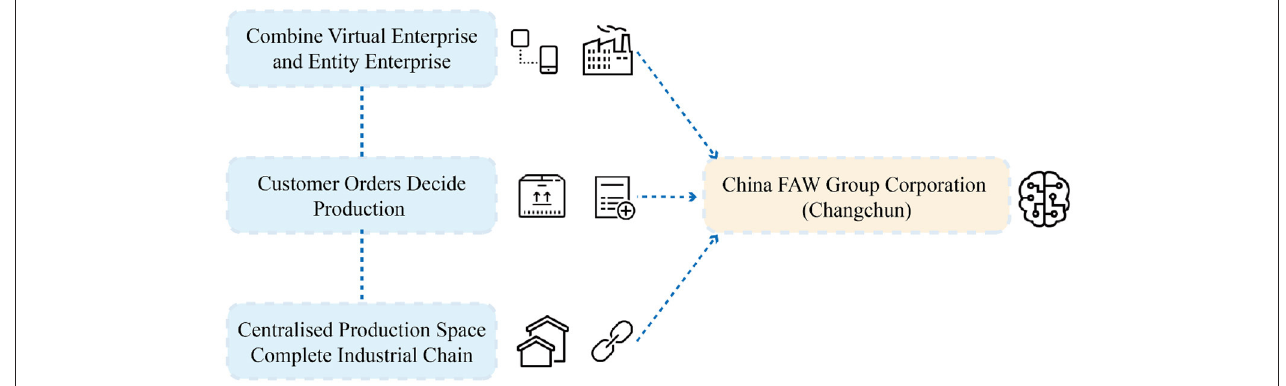
FIGURE 10 | Model for creating resilient industries (Source: